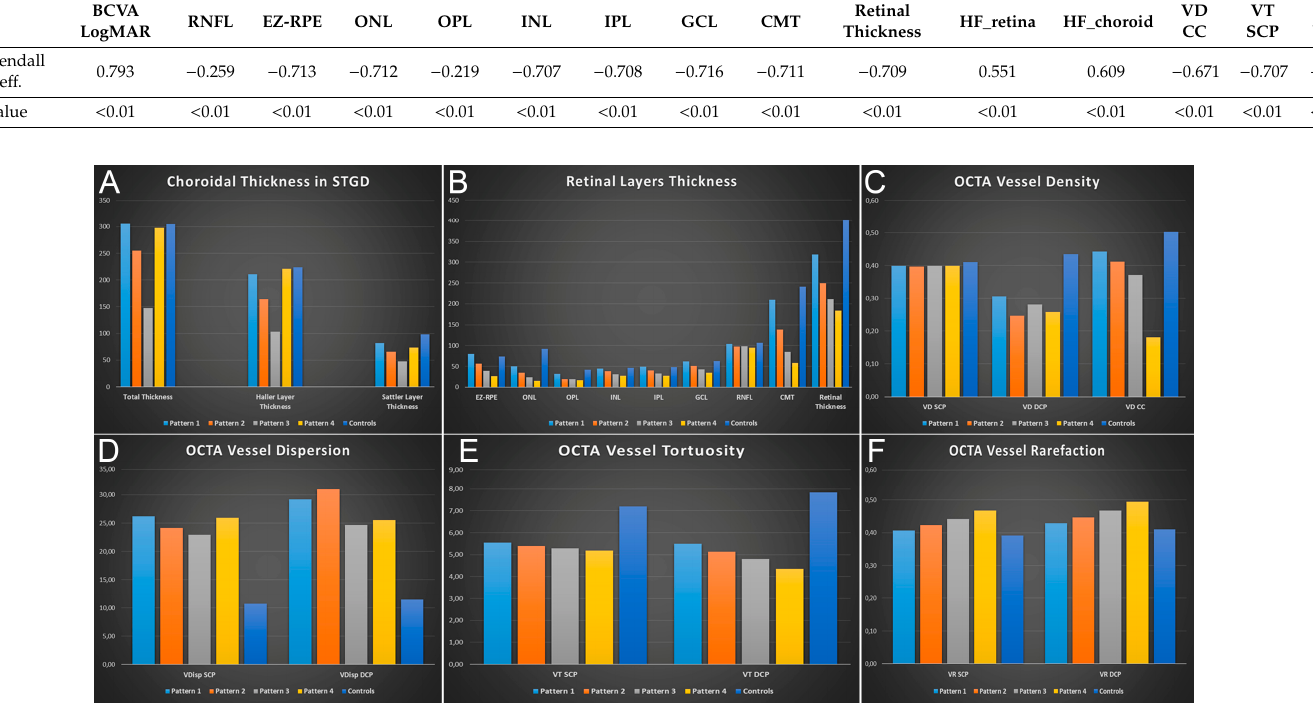
Figure 2. Bar graphs showing all the quantitative analyses performed at baseline. In particular, the parameters for each choroidal pattern are shown as follows: ( A ) choroidal thickness; ( B ) thickness of each retinal layer; ( C ) vessel density of superficial (SCP), deep (DCP) and choriocapillary (CC) vascular plexa; ( D ) vessel dispersion of SCP, DCP and CC vascular plexa; ( E ) vessel tortuosity of SCP, DCP and CC vascular plexa; ( F ) vessel rarefaction of SCP, DCP and CC vascular plexa. All the parameters and the p values are extensively reported in Table S1 and Table S2 of the Supplementary Materials.